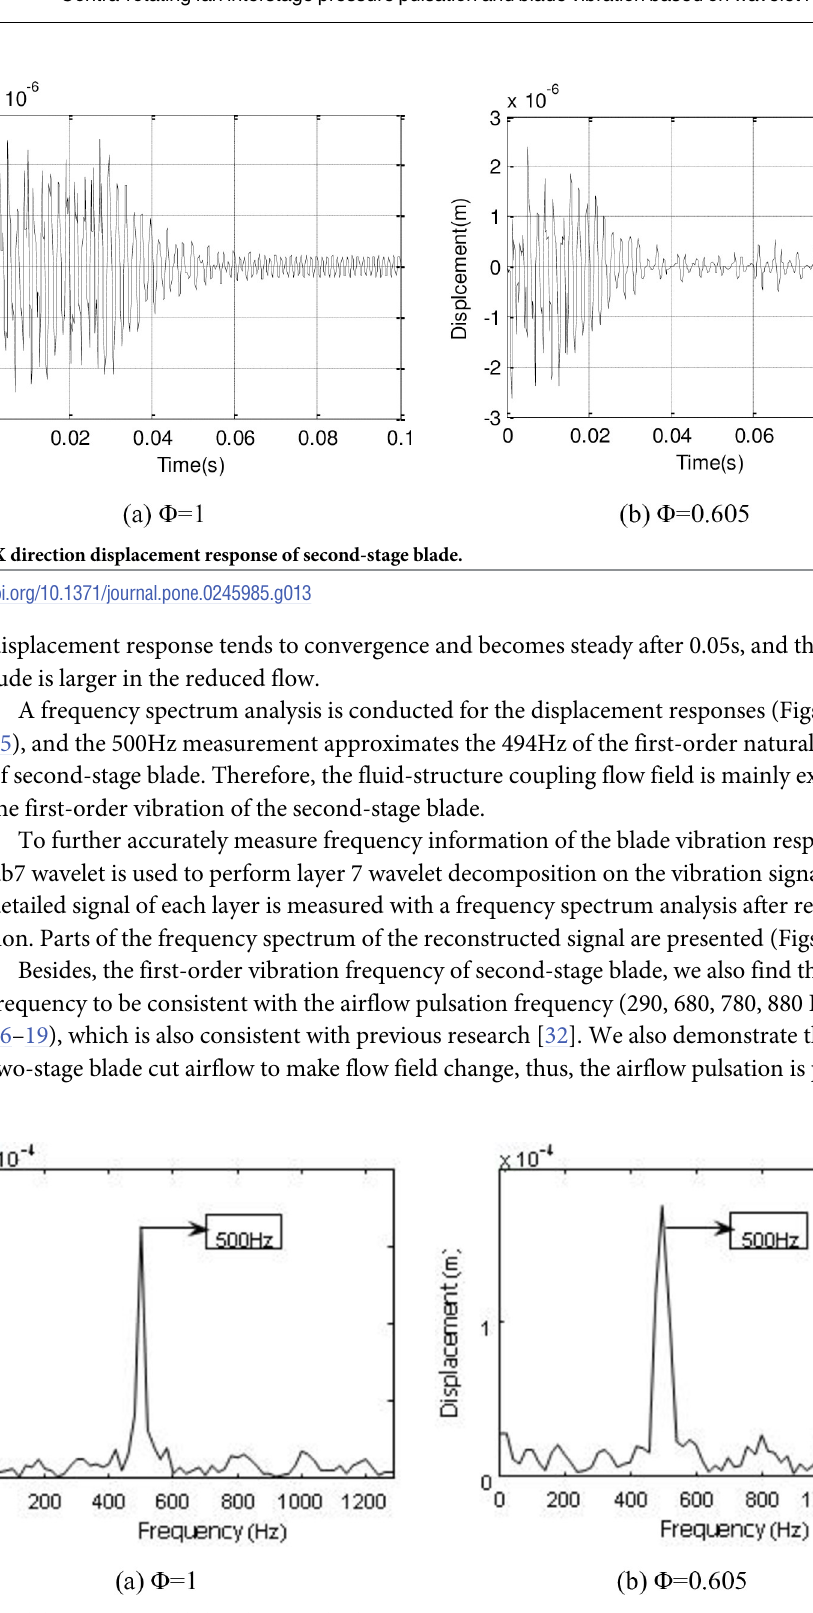
Fig 14. FFT of the second stage blade Y direction displacement